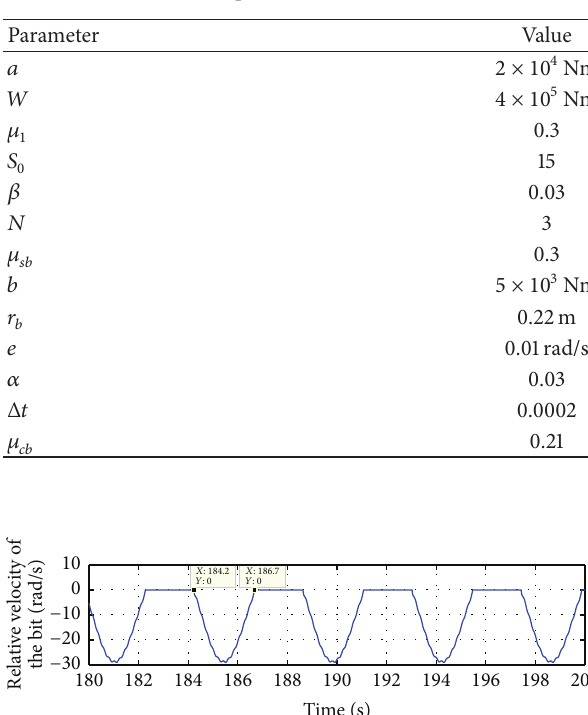
Table 1: Drill string parameters. Table 2: Other parameters used in simulation.